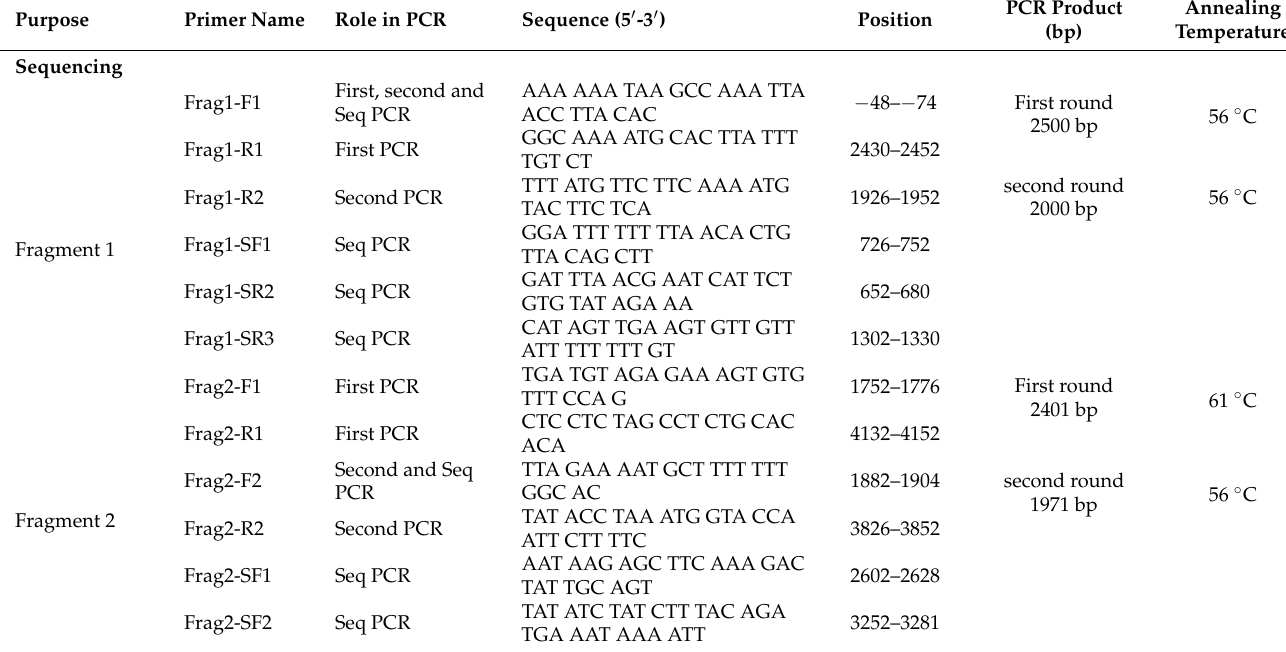
Table 1. Sequences and features of primers used in nest/seminest PCR and Real-Time